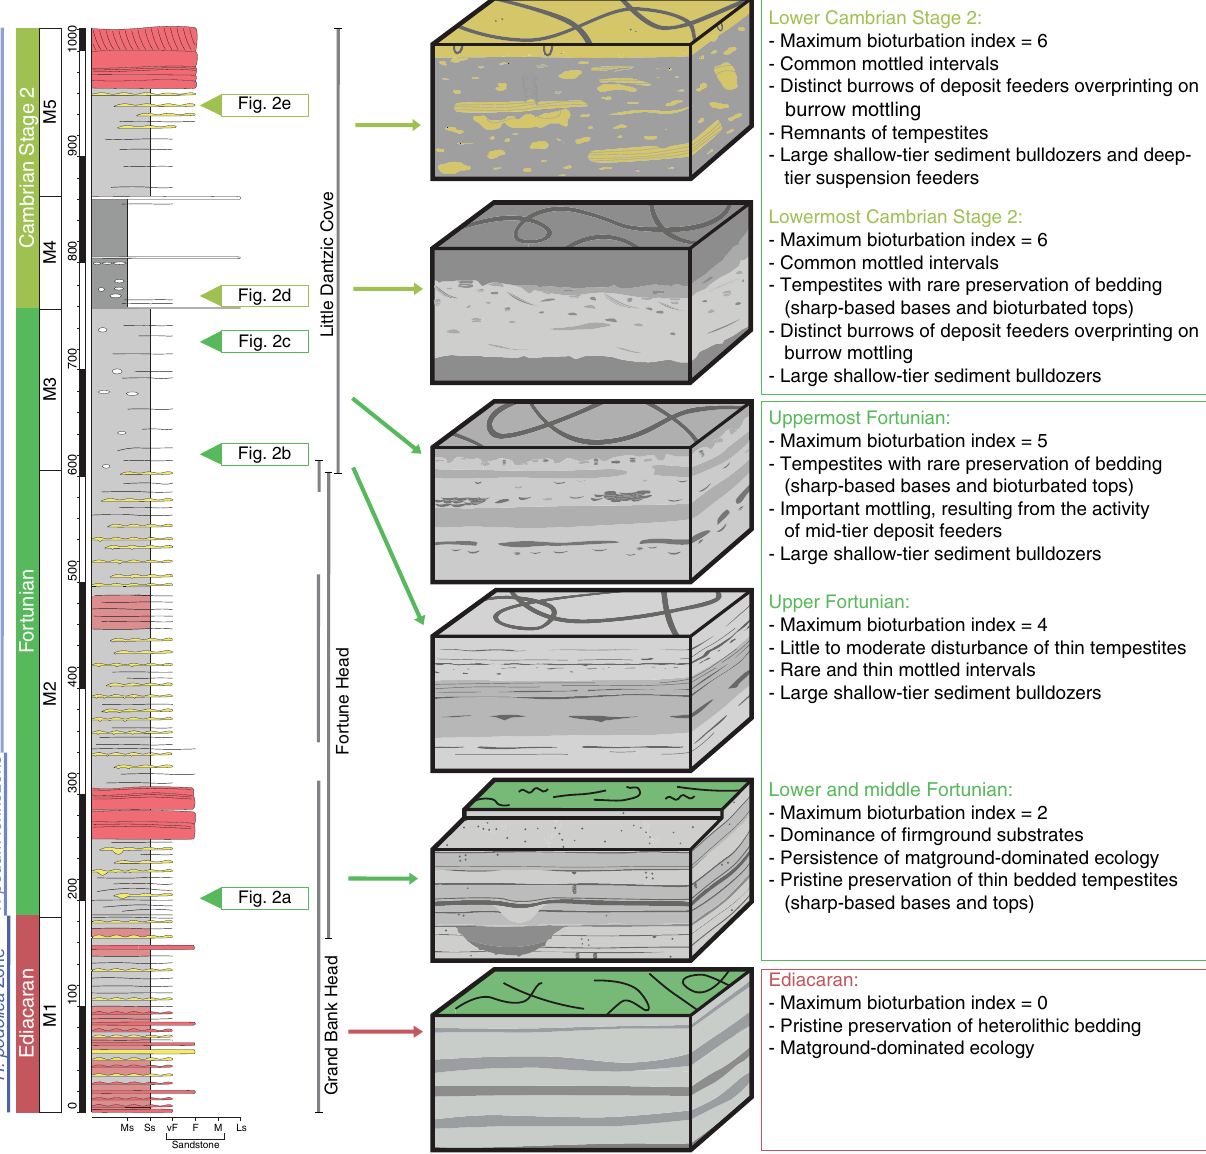
Fig. 1 Stratigraphic column of the Chapel Island Formation showing the change in degree of sediment mixing. Block diagrams summarize the change in sedimentary fabric and intensity of bioturbation, revealing the establishment of a sediment mixed layer at the base of Cambrian Stage 2. M1 to M5 refers to the fi ve members of the Chapel Island Formation (CIF). Scale is in